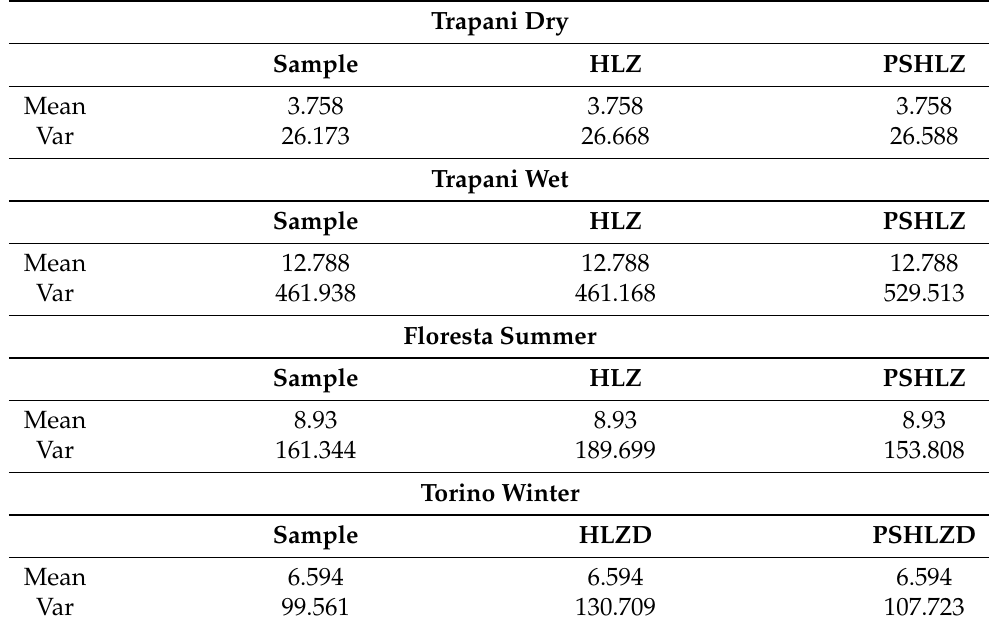
Table 1. The sample means and the sample variances for the 4 selected samples are given in the first column. The means and the variances of the fitted HLZD and of the fitted PSHLZD are given in the second and in the third column